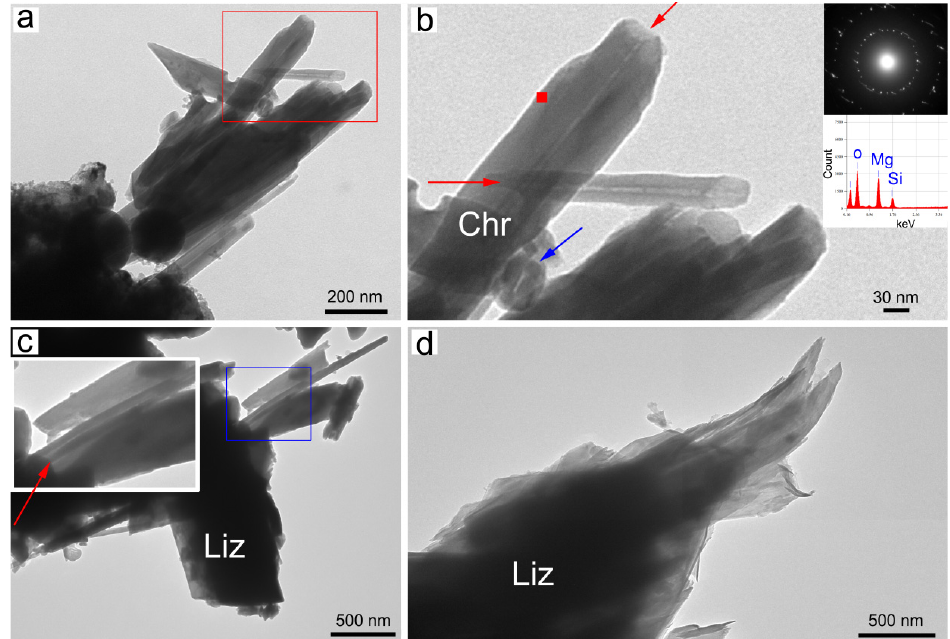
Figure 12. Transmission electron micrographs of samples M ‐ 17 ( a , b ) and M ‐ 12 ( c , d ). ( a ) The classic tube morphology of chrysotile can be observed. ( b ) Magnification of ( a ) indicated in the empty red square. The red arrows indicate the chrysotile core, which always runs empty longitudinally along the fibre’s axis. The blue arrow indicates a chrysotile fibre section perpendicular to its direction of elongation. Top right chrysotile SAED and chemical analysis (EDS/TEM) both acquired at the point indicated by the solid red square. ( c ) Chrysotile and lizardite magnification indicated in the empty blue square. The red arrows indicate the chrysotile core. ( d ) Lizardite showing plate ‐ like morphol ‐ ogy.